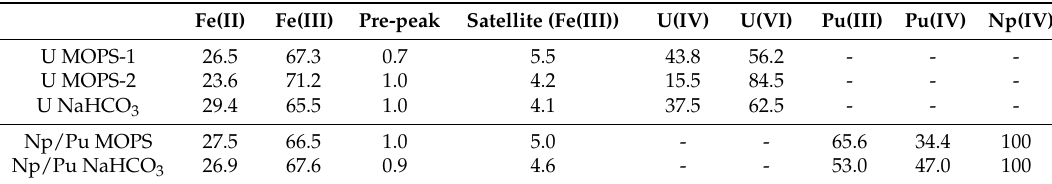
Table 2. Summary of the fits to the XPS results from the U (Figure 2d,e) and the Np (Figure 3d,e) samples; the values represent the percentages of the fitted areas of the peaks associated with the different redox states of Fe, U, Pu and Np; the U MOPS sample was analysed on two locations, denoted by − 1 and −